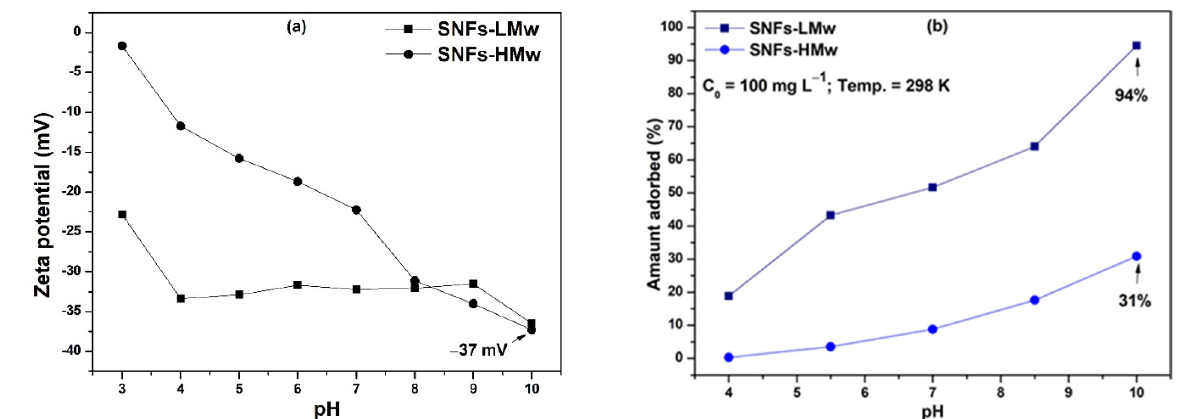
Figure 7. Comparative results of SNFs-LMw and SNFs-HMw adsorbents of ( a ) zeta potential and ( b ) pH effect of MB adsorption.